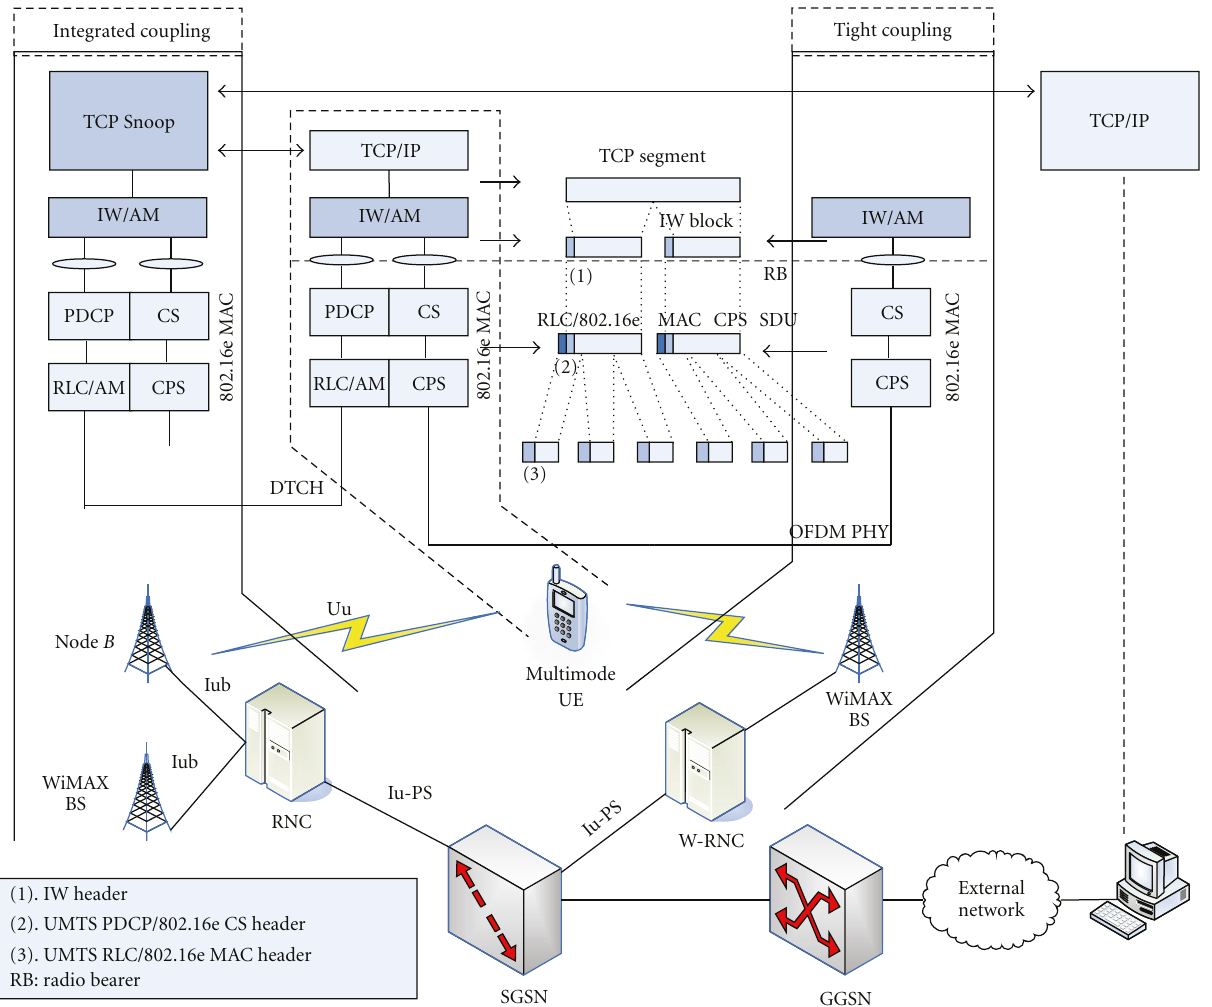
Figure 2: User plane protocol stacks in integrated coupling (left) and tight coupling (right)